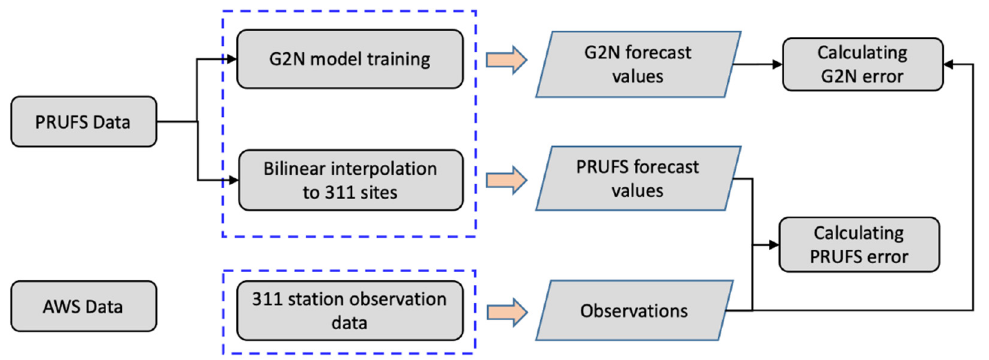
Figure 3. Flow chart of data pre ‐